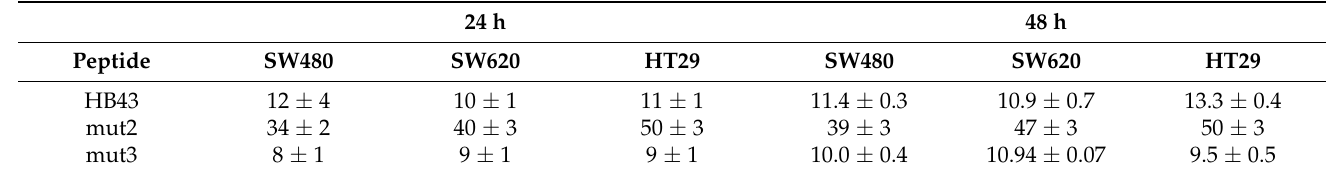
Table 1. Half-maximal inhibitory concentration (IC 50 ) of HB43, mut2 and mut3 peptides ( µ M) in colon cancer cell lines SW480, SW620, and HT29 after 24-h and 48-h